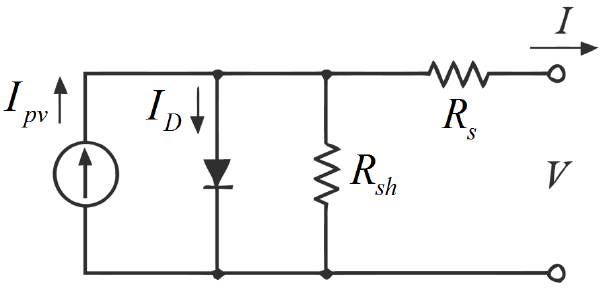
Figure 1. Equivalent circuit of a solar panel.